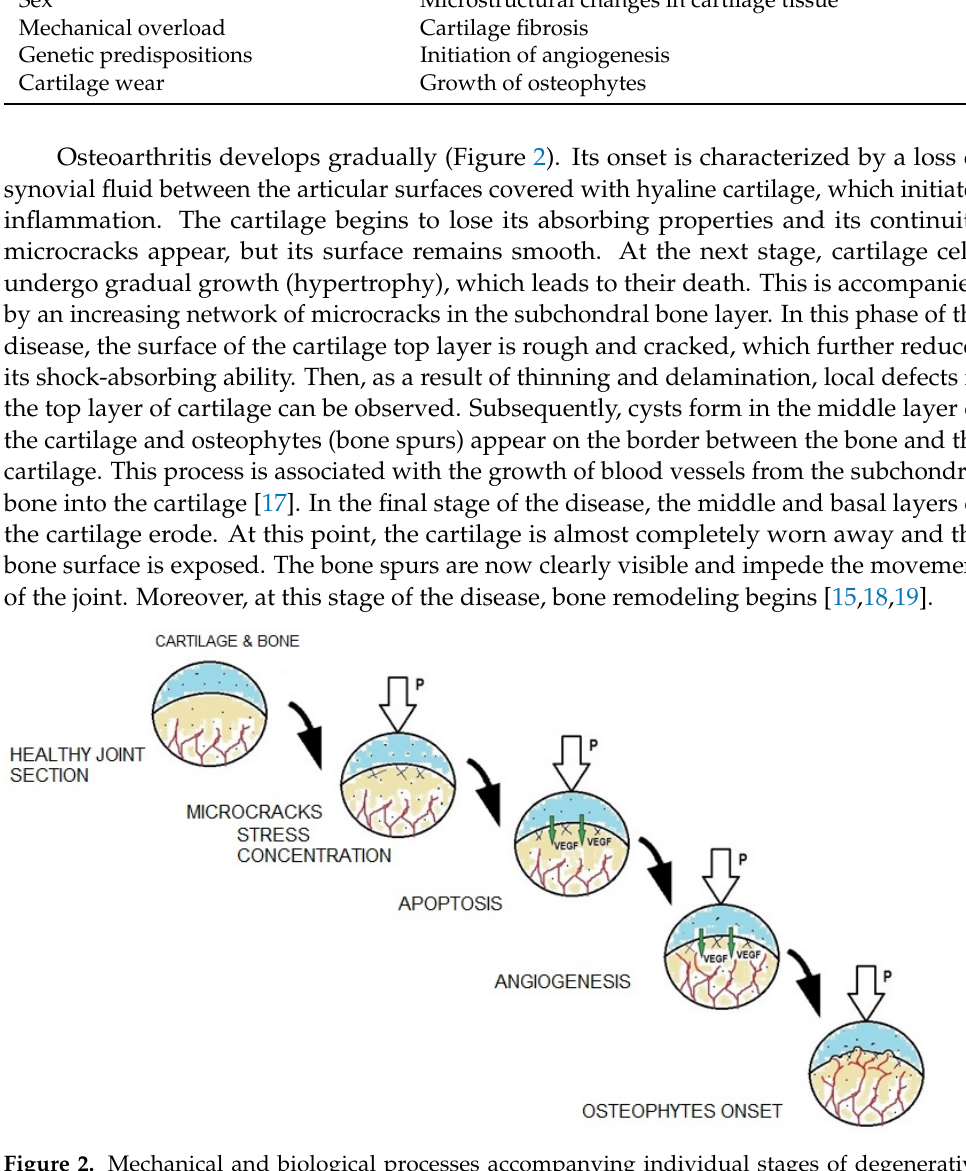
Figure 2. Mechanical and biological processes accompanying individual stages of degenerative changes.